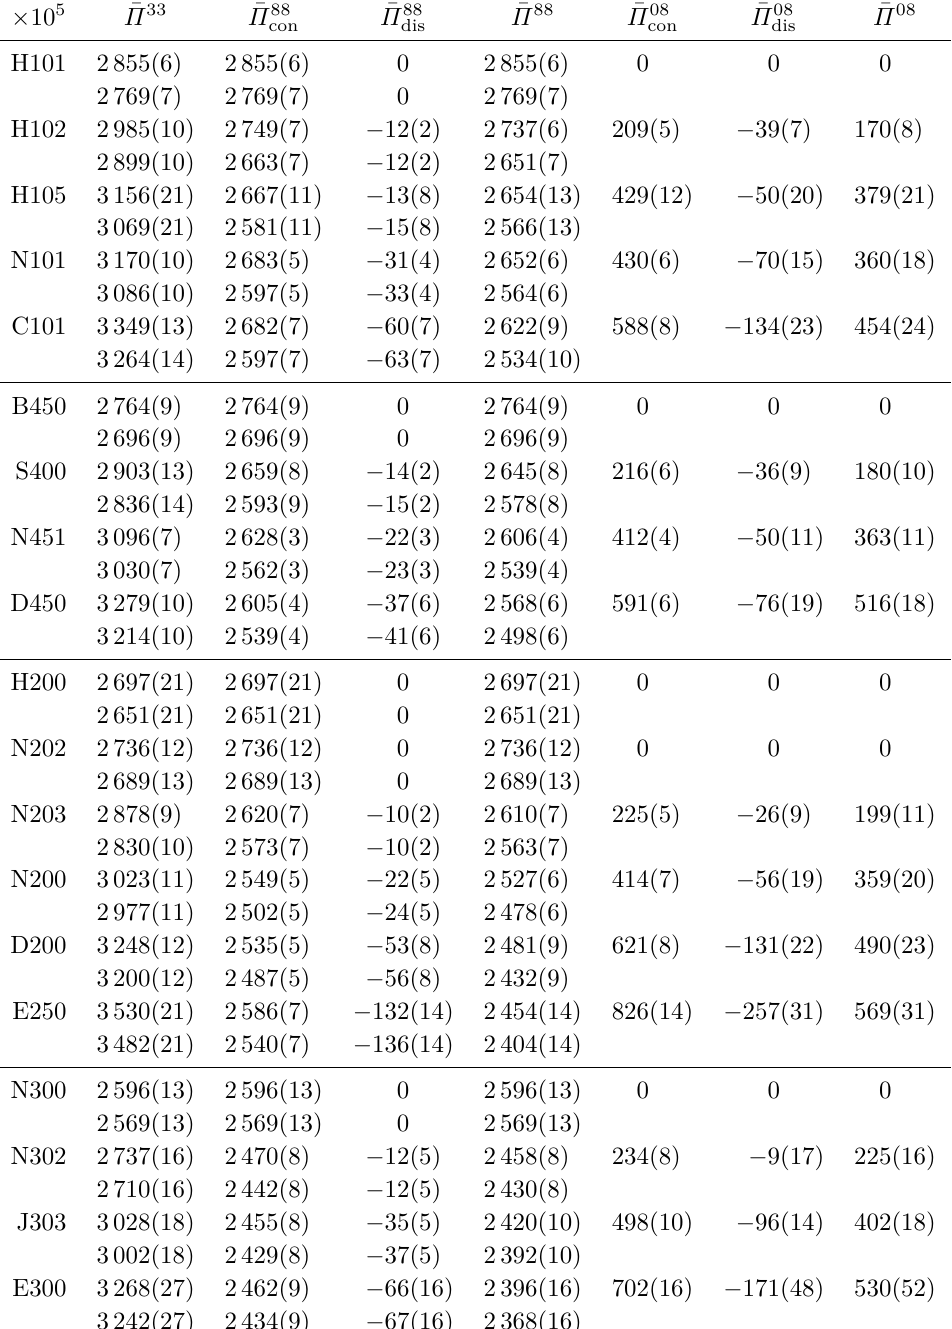
Table 4 . Estimate of connected and disconnected contribution to ¯ Π ( − Q 2 ) × 10 5 at Q 2 = 1 GeV 2 for the conserved-local (first line) and, when available, local-local (second line) discretization. Contributions tabulated as 0 vanish exactly due to SU(3)-symmetry. The contributions are estimated applying the bounding method as explained in section 3.6 and the correction for finite-size effects as of section